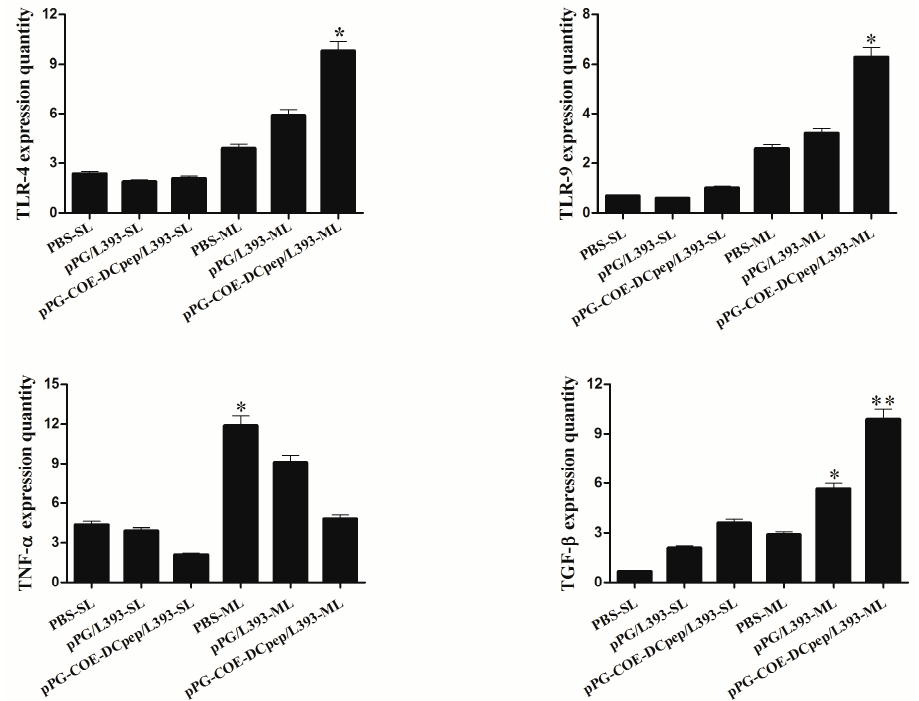
Figure 8. Cytokines and toll-like receptor (TLR) expression. RNA expression was analyzed in splenic lymphocytes (SL) and mesenteric lymph node (ML) of the pPG-COE-DCpep/L393 , pPG/L393 , and PBS groups. Total RNA was used to analyze the expression of TNF- α , TGF- β , TLR-4, and TLR-9. The differences between means were considered as significant at * p < 0.05 and very significant at ** p < 0.01.